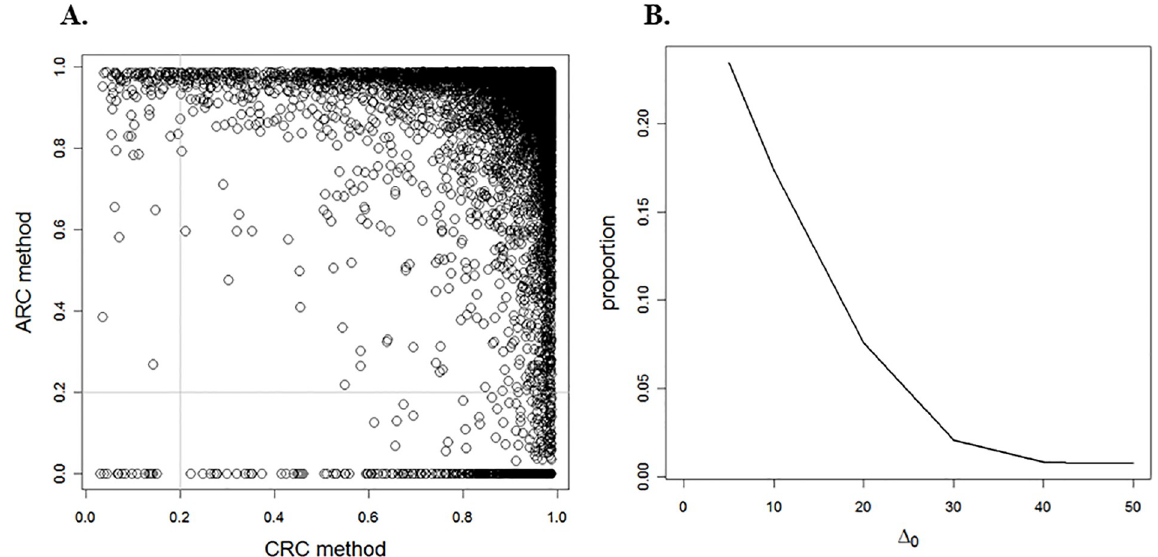
Fig 4. Brain data analysis. (A) presents the LFDR estimate under the ARC method for Δ 0 = 20 versus that for the CRC method and (B) illustrates the proportion of dislexic-non-dyslexic difference voxels under the ARC method when the LFDR estimate is less than 0.2 versus Δ 0 2 (0,